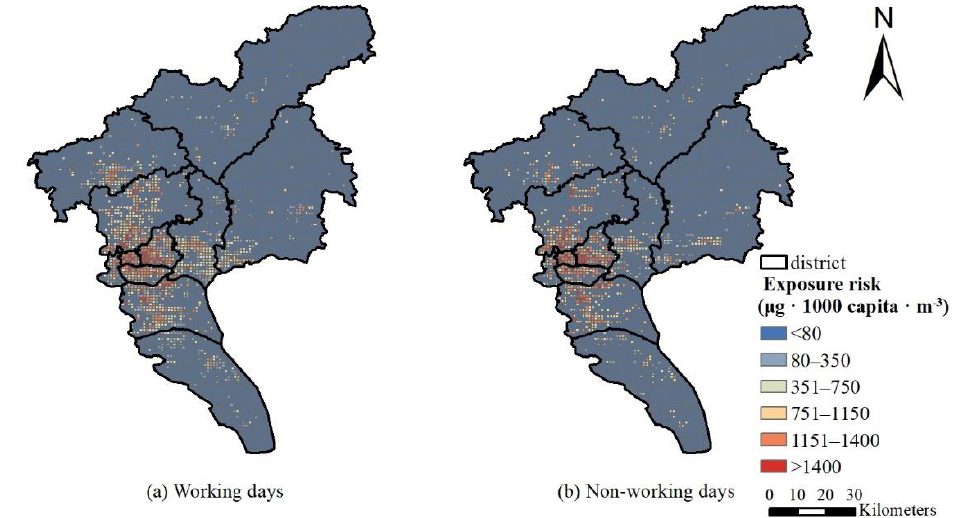
Figure 7. Population exposure risk distribution in September 2021: ( a ) working days; ( b ) non- working days.